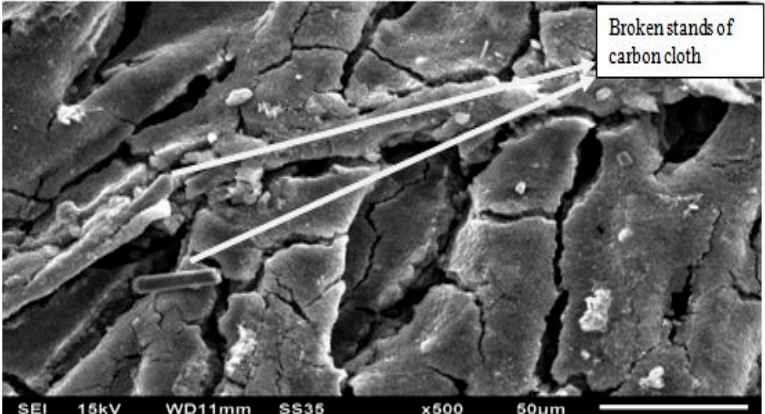
Figure 18. Scanning Electron Microscopy (SEM) image of the oxygen side carbon cloth used as a gas diffusion layer.